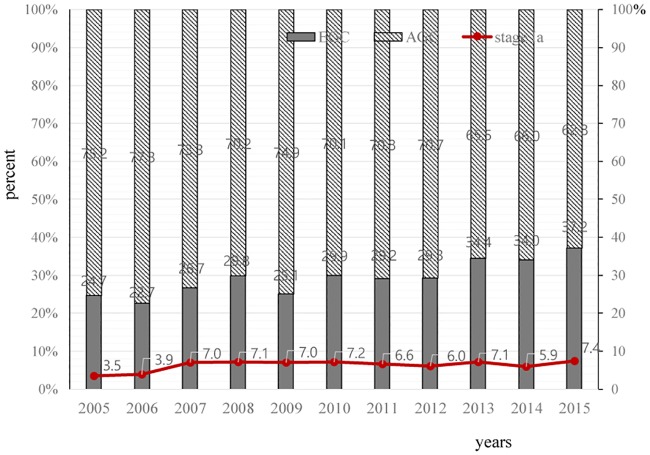
Temporal trends for early esophageal carcinoma among all esophageal cancers.The proportion of early esophageal cancers significantly increased from 24.7% in 2005 to 37.2% in 2015 (P<0.001). However, the proportion of stage Ia cases (mucosal cancer), which could be treated using endoscopy, remained relatively stable.